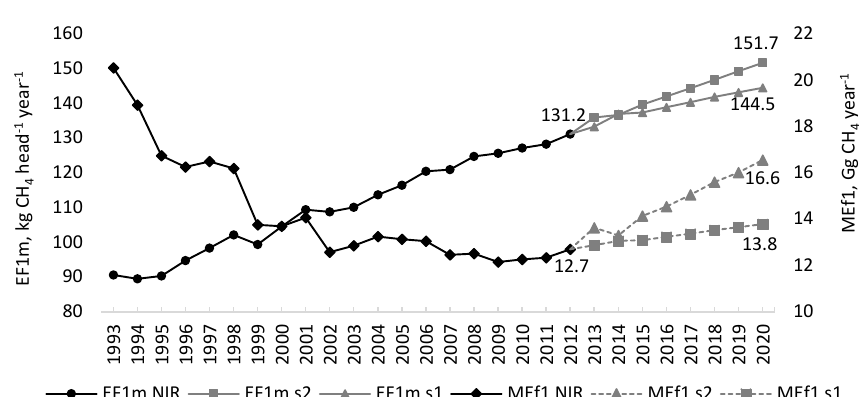
Fig. 5. Actual and projected EF of CH year -1 ) from enteric fermentation in 1993−2020 (projections of the Estonian agricultural model, Estonian NIR 2014, Estonian CRF 2014)